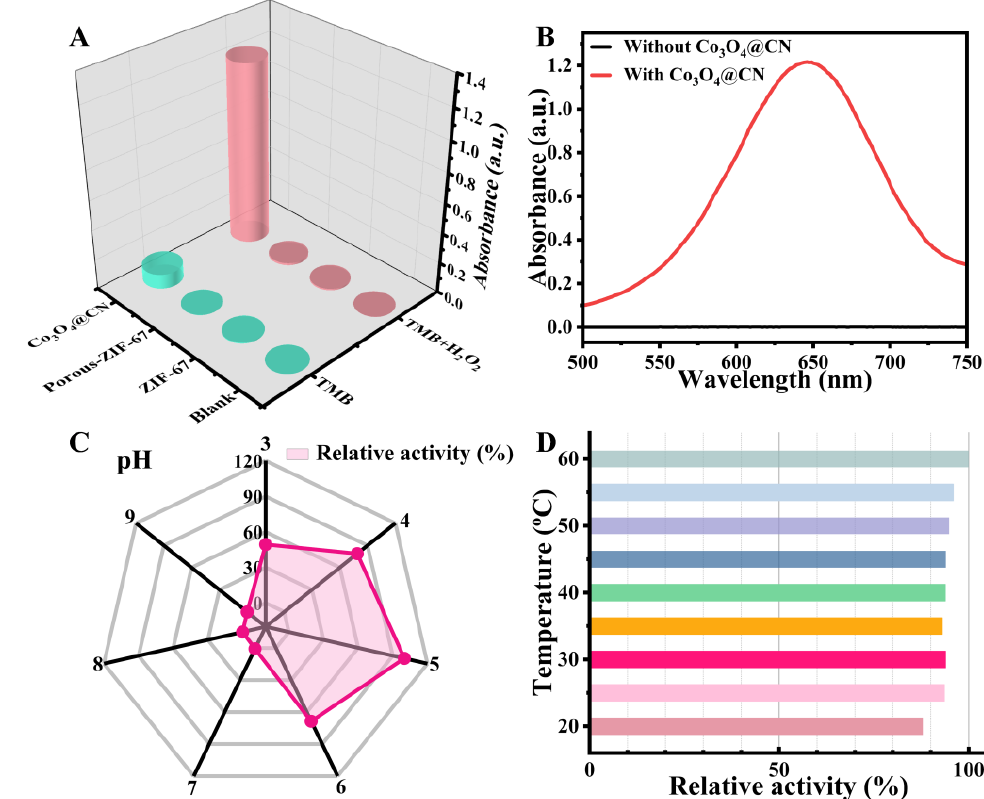
Figure 3. (A) Absorbance at 652 nm for the different reaction systems. (B) The UV-visible absorption spectra in the range of 500 to 750 nm before and after the addition of Co 3 O 4 @CN. (C) Effect of pH on the POD-like activity of Co 3 O 4 @CN. (D) Effect of temperature on the POD-like activity of Co 3 O 4 @CN.